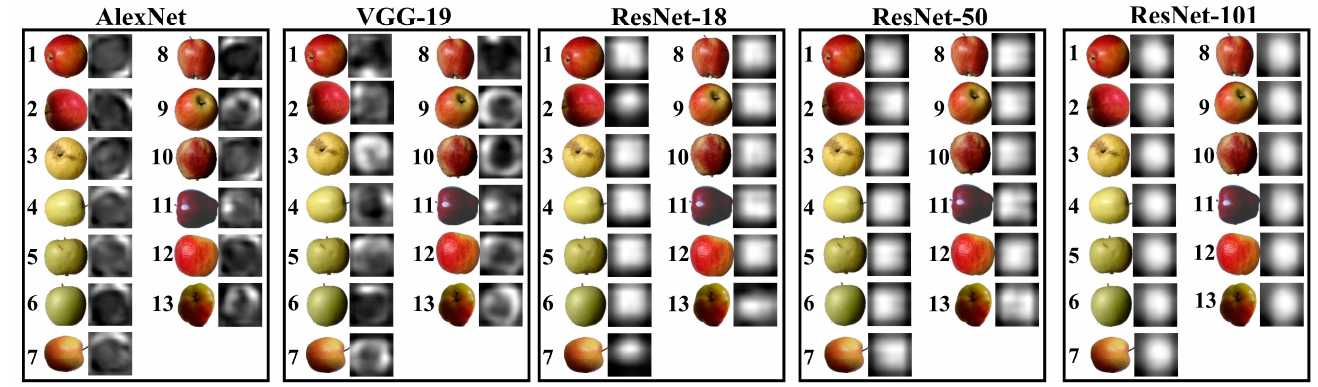
Figure 5. Apple images of each class and the corresponding strongest activations of the last convo- lutional layer of the different trained models. The numbers on the images correspond to the class of apple.